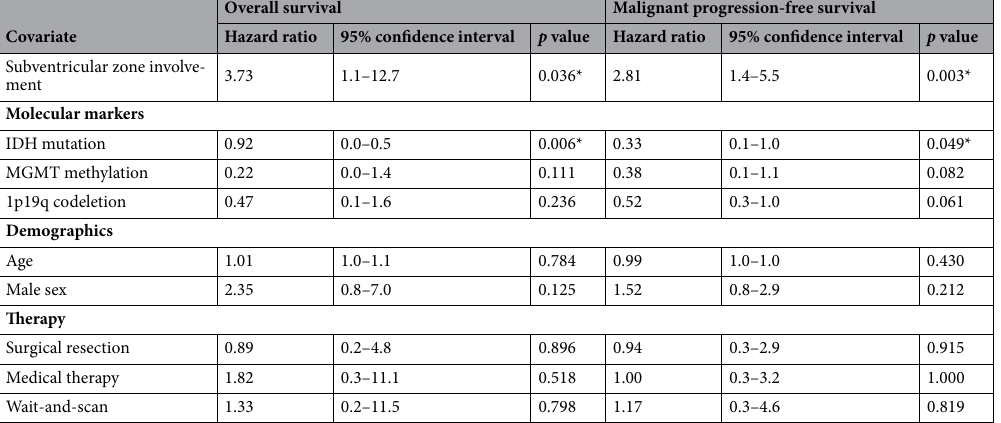
Table 2. Multivariate Cox’s overall survival and malignant progression-free survival analysis. Multivariate overall survival and malignant progression-free survival analysis was performed among WHO grade 2 glioma patients (n = 182) using clinical and molecular covariates. Molecular markers, sex, and therapeutic approaches were tested as dichotomous variables, and age was tested as continuous variable. Hazard ratio, 95% confidence interval, and p value are given for analyzed covariates. Asterisks indicate p ≤ 0.05. IDH isocitrate dehydrogenase 1/2, MGMT O6-methylguanine-DNA methyltransferase